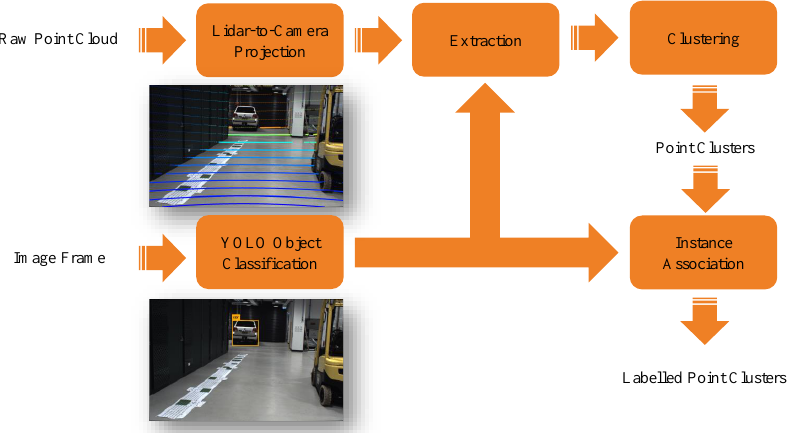
Figure 2. The sensory data processing pipeline within the IRSU.